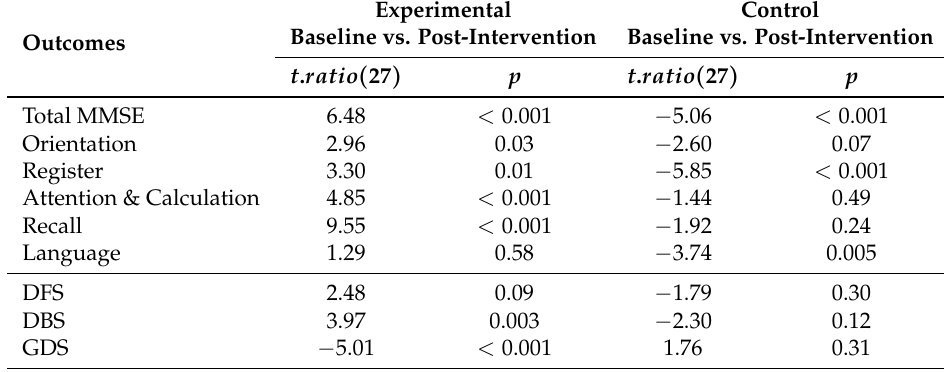
Table A6. Tuckey’s post hoc test results between baseline and post-intervention tests in the experimental and the control groups.